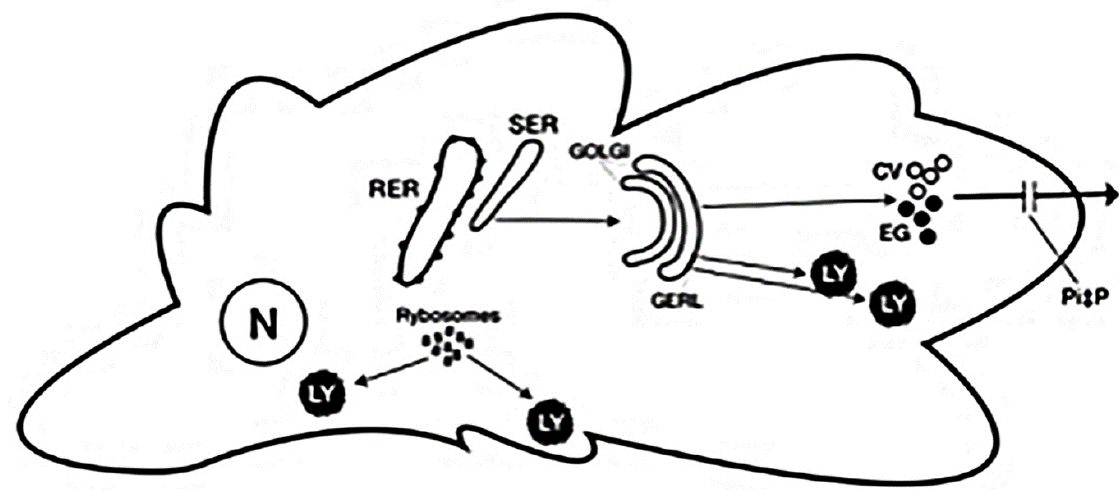
Figure 7. Schematic representation of the possible intracellular pathways of AAT in macrophages, polymorphonuclear leucocytes, mast cells, Paneth cells, endocrine cells. AAT synthesized in the RER reaches the Golgi apparatus and is stocked within condensing vacuoles (empty circle) or endocrine granules (black dots) or lysosomes (Ly). In the GERL area AAT recognizes specific endomembrane receptors and is diverted to lysosomes. In condensing vacuoles, endocrine granules, AAT is supposed to bind protease (Pi/P complex). After AAT cleavage (gate), proteases get activation. AAT synthesized by free ribosomes can be addressed directly to lysosomes (Ly). The dark color of endocrine granules and lysosomes reflects the electrondensity of their matrix.